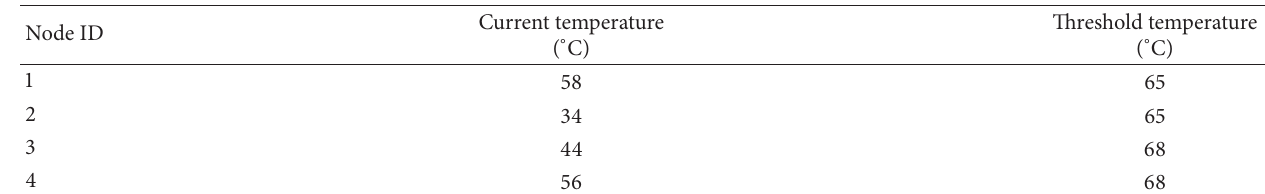
Table 3: Unified list (S1).